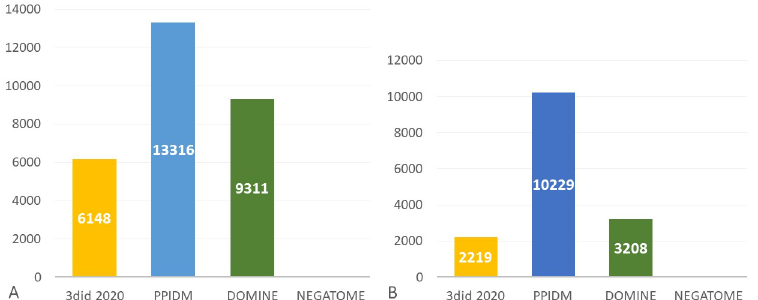
Fig 4. Coverage of PPI interactome derived from IMEx database (50,032 PPIs). (A) Number of PPIs covered by at least one DDI; (B) Number of DDIs covering at least one